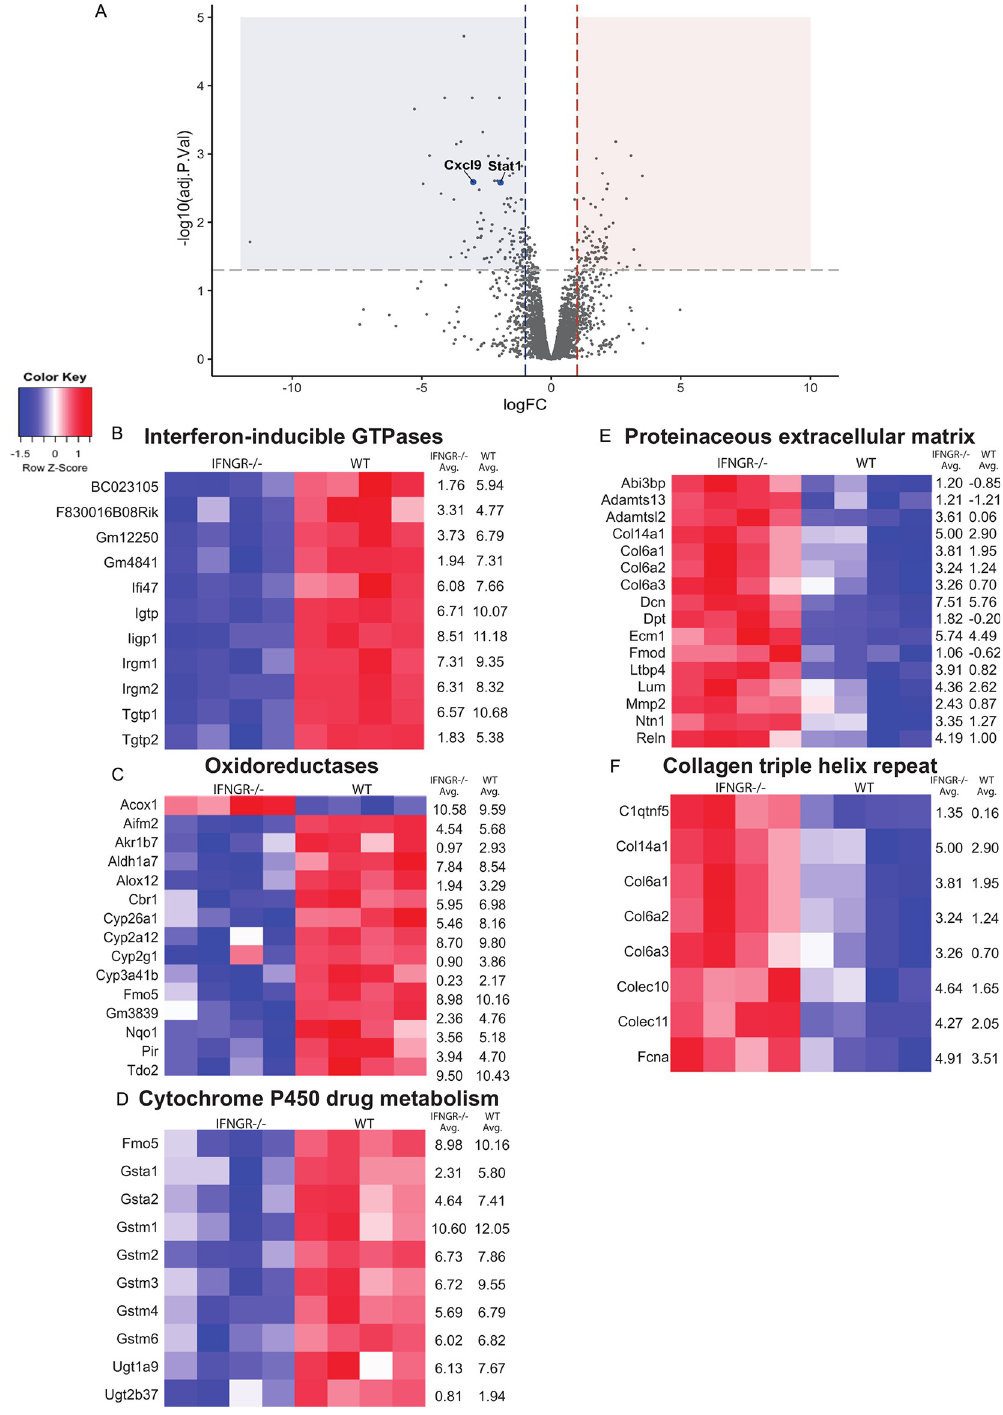
Fig 5. Non-hematopoietic IFN- γ response increases cellular stress response and reduces ECM production in the liver. Mice with IFNgR+/+ BM and either IFNgR+/+ or IFNgR-/- livers (n = 4 per group) were sacrificed 8 days after LCMV infection to induce FHL hepatitis and livers were harvested for mRNAseq analysis. (A) Volcano plot comparing genes that transcripts were decreased (shaded in blue) and increased (shaded in red) in IFNgR-/- livers when compared to IFNgR+/+ livers as reference. X axis notes the log fold change (logFC) using IFNgR+/+ livers as reference and Y axis notes the log adjusted p value [-log10(adj.p.val)]. Heatmaps showing relative expression from the individual genes from the pathways (B-D) upregulated and (E-F) downregulated by the presence of IFN γ - R according to GO analysis using DAVID. Genes